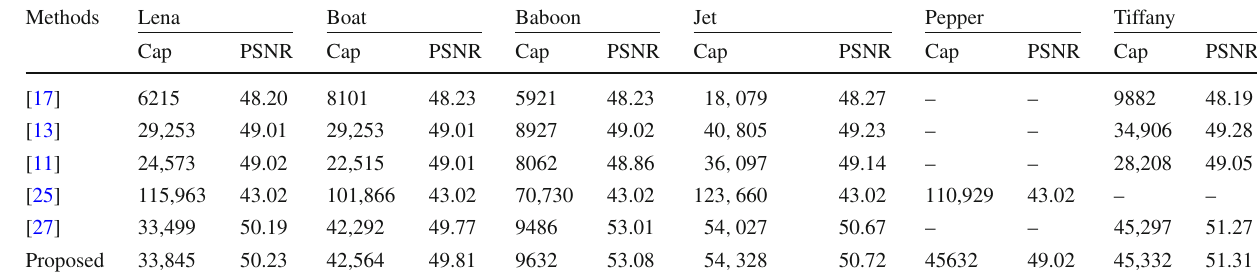
Table 3 Evaluation of CDMBP with block division 16 × 16 and different bit planes; (Ni et al. [17], Luo et al. [13], Kim et al. [11], Lin et al. [25], Liu et al. [27], He et al. [32])